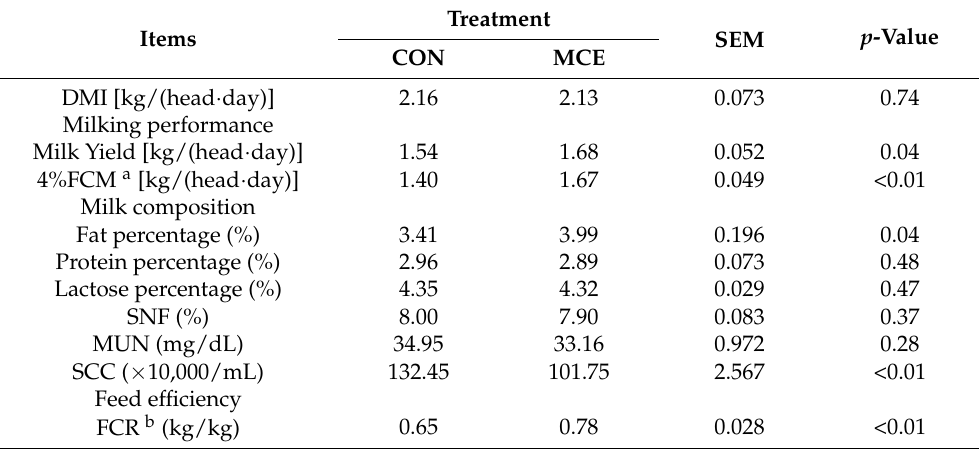
Table 2. Effect of MCE on dry matter intake, milking performance, and milk composition.